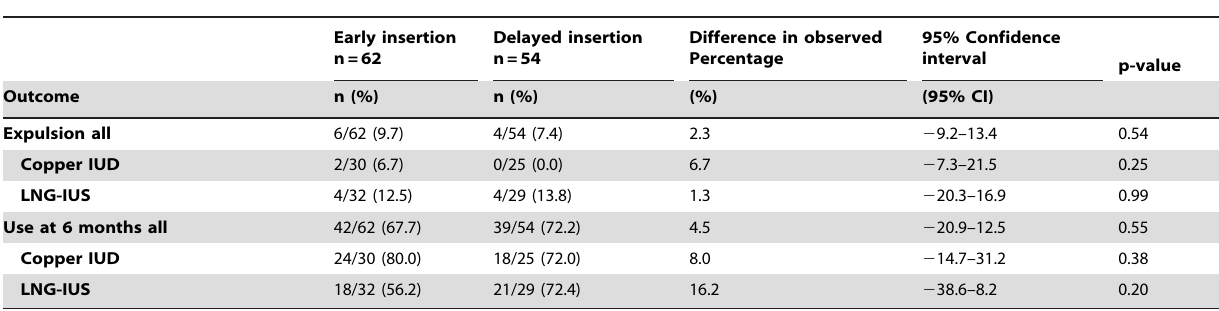
Table 2. Outcomes of Early versus Delayed IUC insertion after medical abortion.